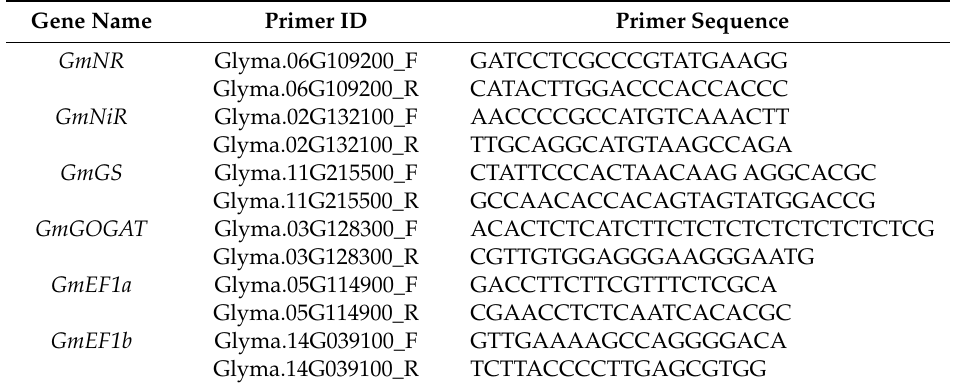
Table 1. Specific primers used in this